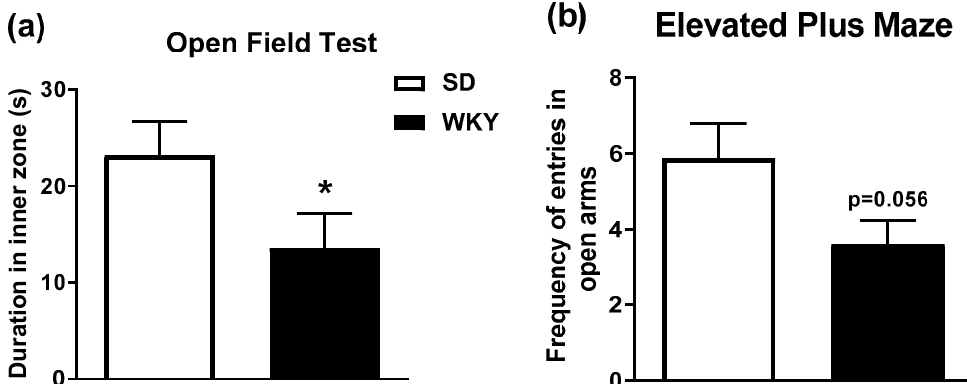
Figure 1. WKY rats display reduced ( a ) duration of time spent in inner zone in open field (* p < 0.05 vs. SD) and ( b ) frequency to enter the open arms of the elevated plus maze ( p = 0.056). Data expressed as mean ± SEM ( n = 15–16 per group).